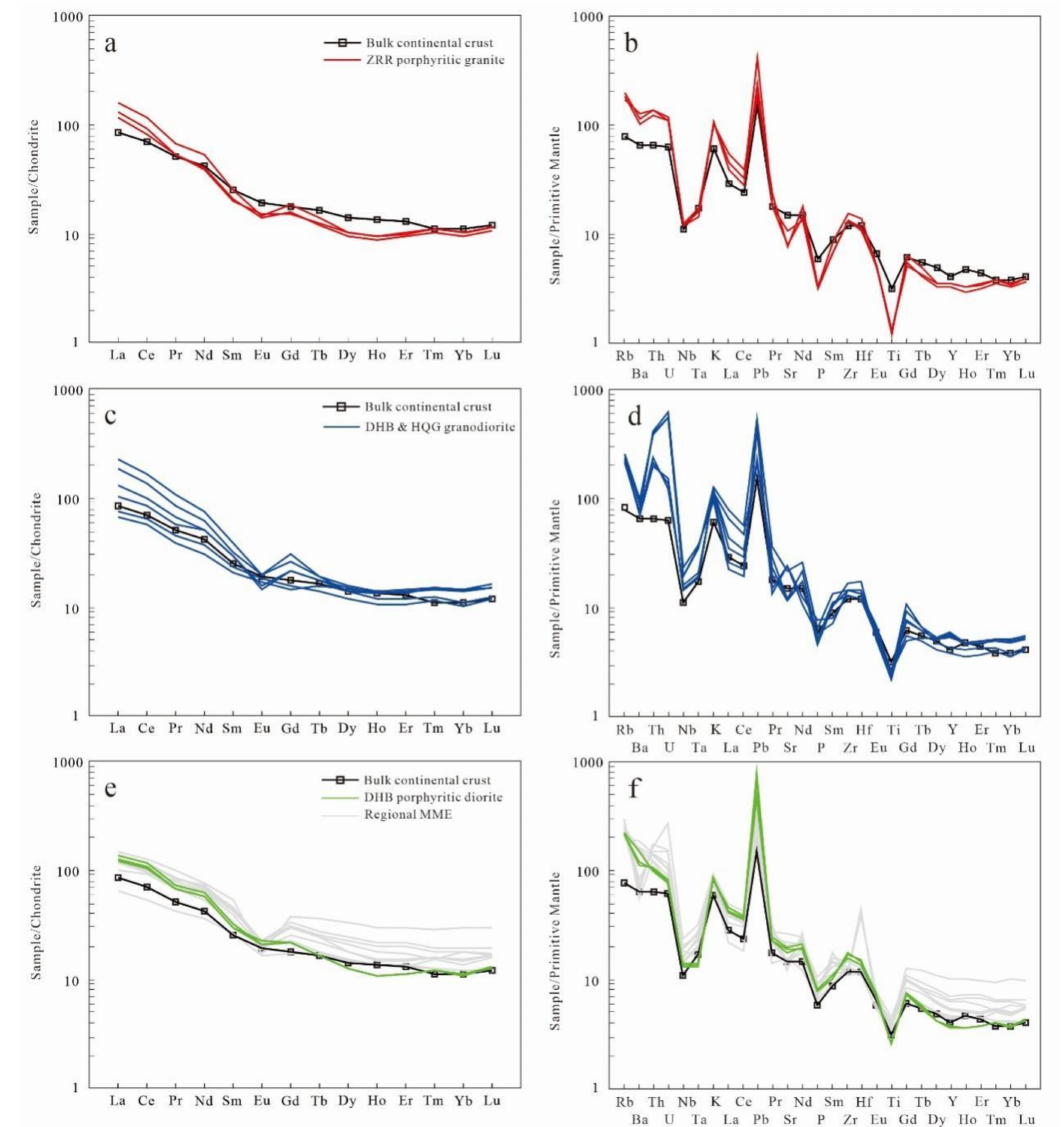
Figure 7. The chondrite-normalized REE patterns and primitive mantle-normalized spider diagrams of trace elements. ( a , b ) ZRR porphyritic granites; ( c , d ) DHB and HQG granodiorite; ( e , f ) DHB porphyritic diorite, the grey line for regional MMEs were from [2,5], and they indicate previous MMEs of the same period of the DHB porphyritic diorites (241–235 Ma) in the east section of the East Kunlun Orogenic Belt. The chondrite values were from [26]. The primitive mantle values were from [27]. The bulk continental crust values were from